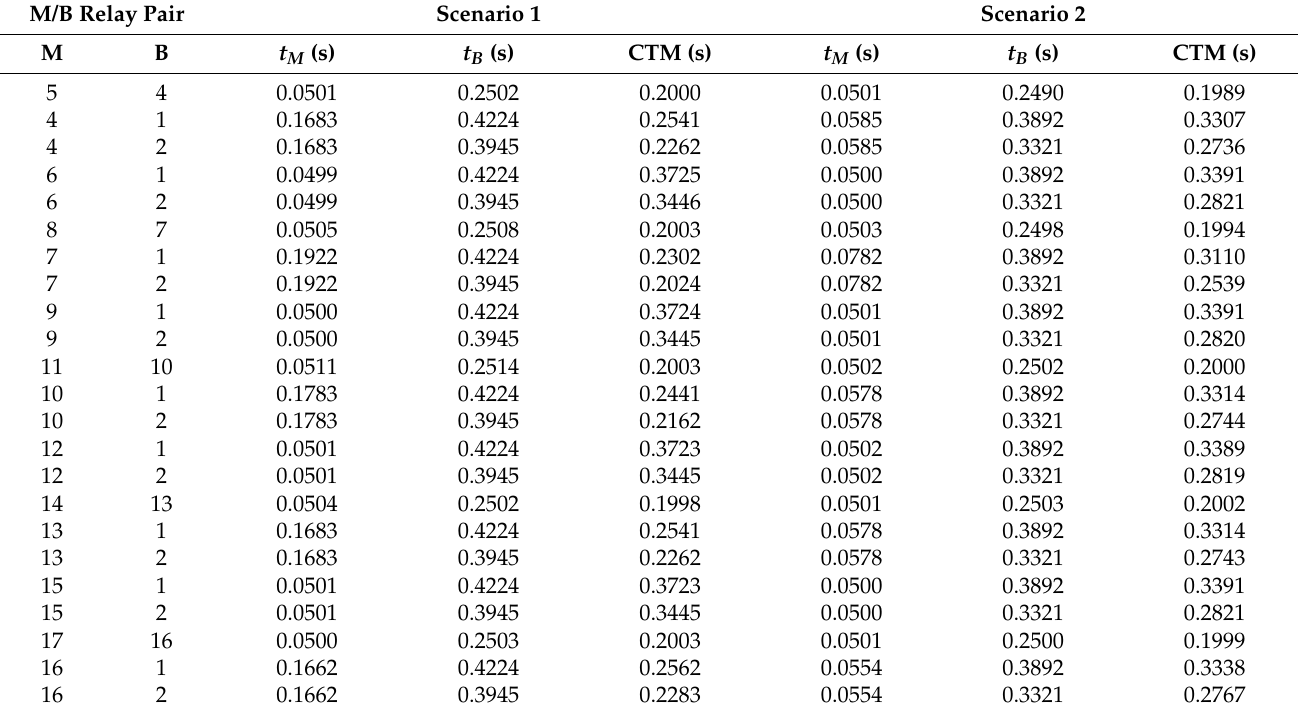
Table 12. Operating times of M/B relay pairs for Agiba Network using Test Model